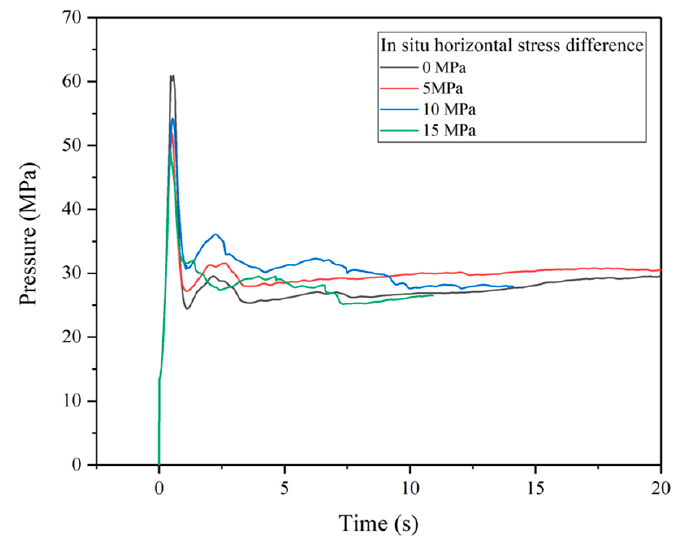
Figure 20. The bottom hole pressure under different in situ horizontal stresses.